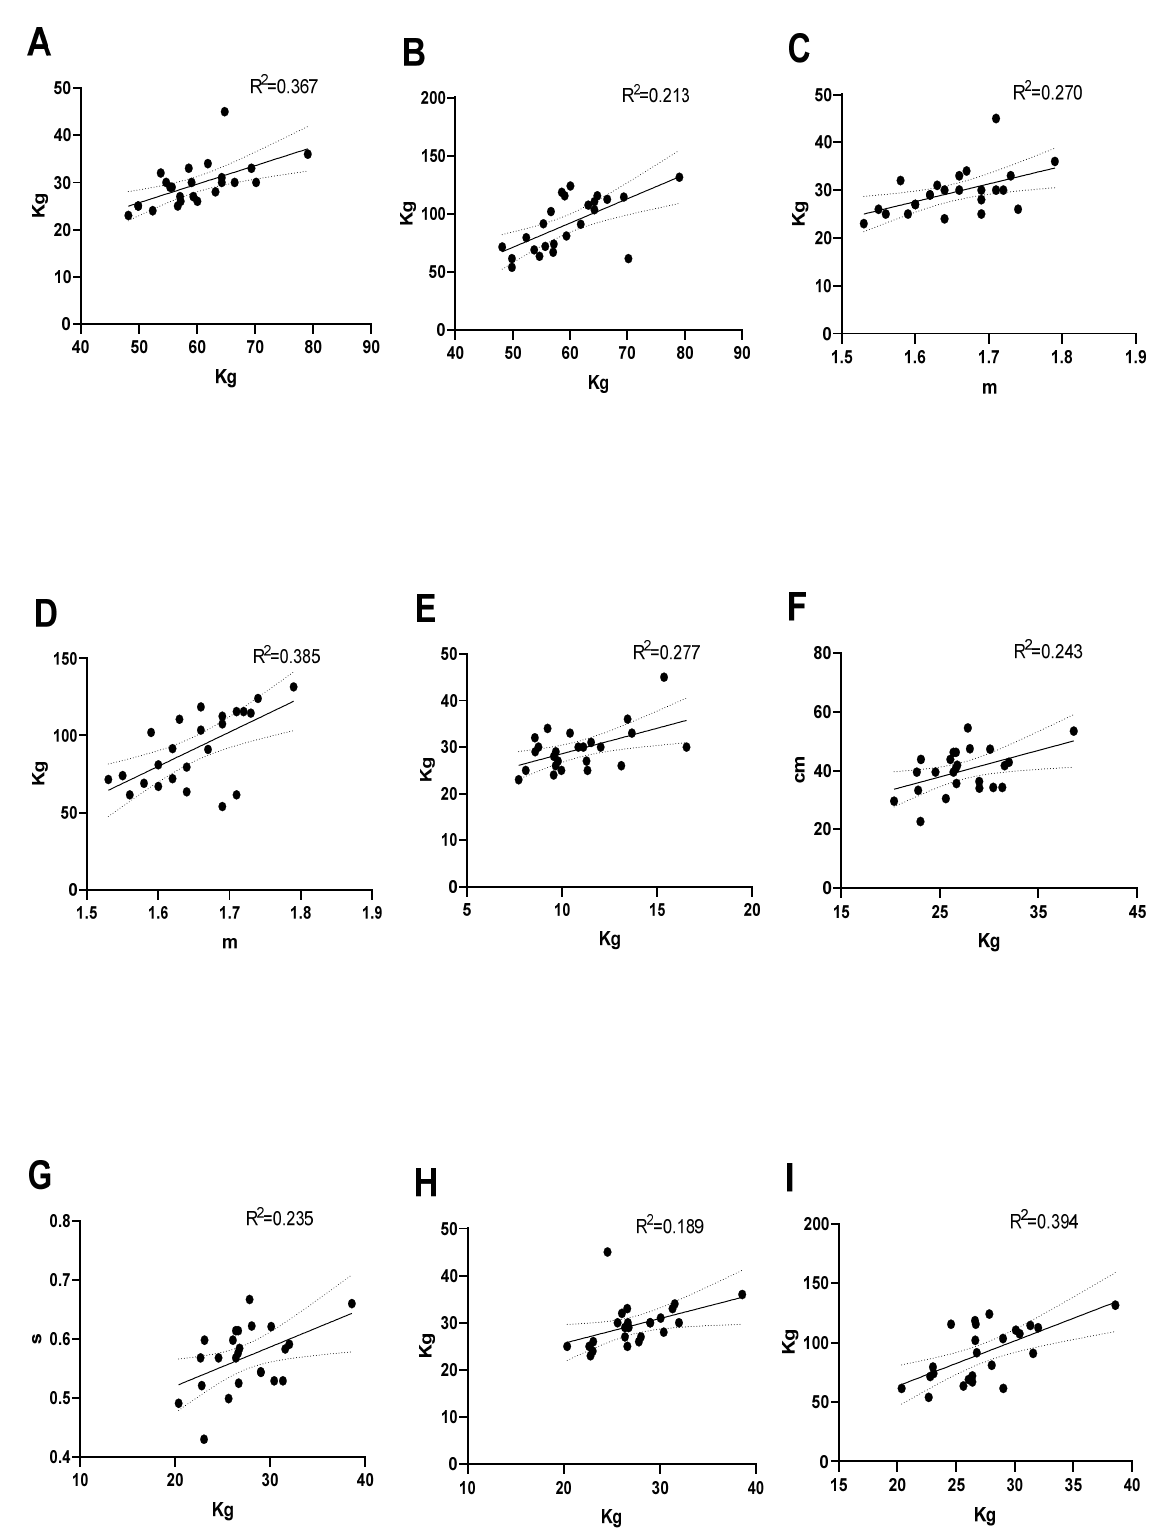
Figure 2. Linear regressions of statistically significant correlations in women soccer players. ( A ) Body mass and hand grip; ( B ) body mass and lower limb isometric strength; ( C ) stretch stature and hand grip; ( D ) stretch stature and lower limb isometric strength; ( E ) fat weight and hand grip; ( F ) muscle mass and CMJ height; ( G ) muscle mass and CMJ flight time; ( H ) muscle mass and hand grip; ( I ) muscle mass and lower limb isometric strength; CMJ: countermovement jump.